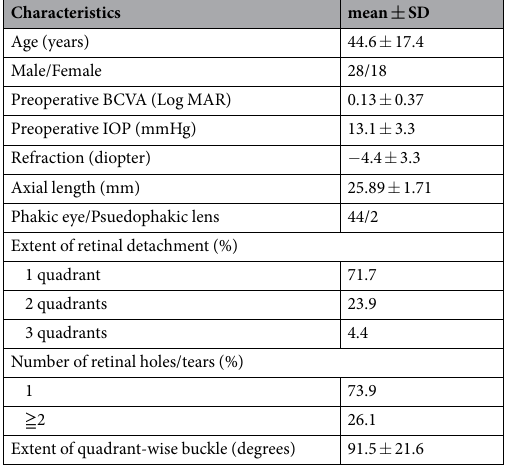
Table 1. Clinical characteristics of subjects. BCVA: best-corrected visual acuity, LogMAR: logarithm of the minimal angle of resolution, IOP: intraocular